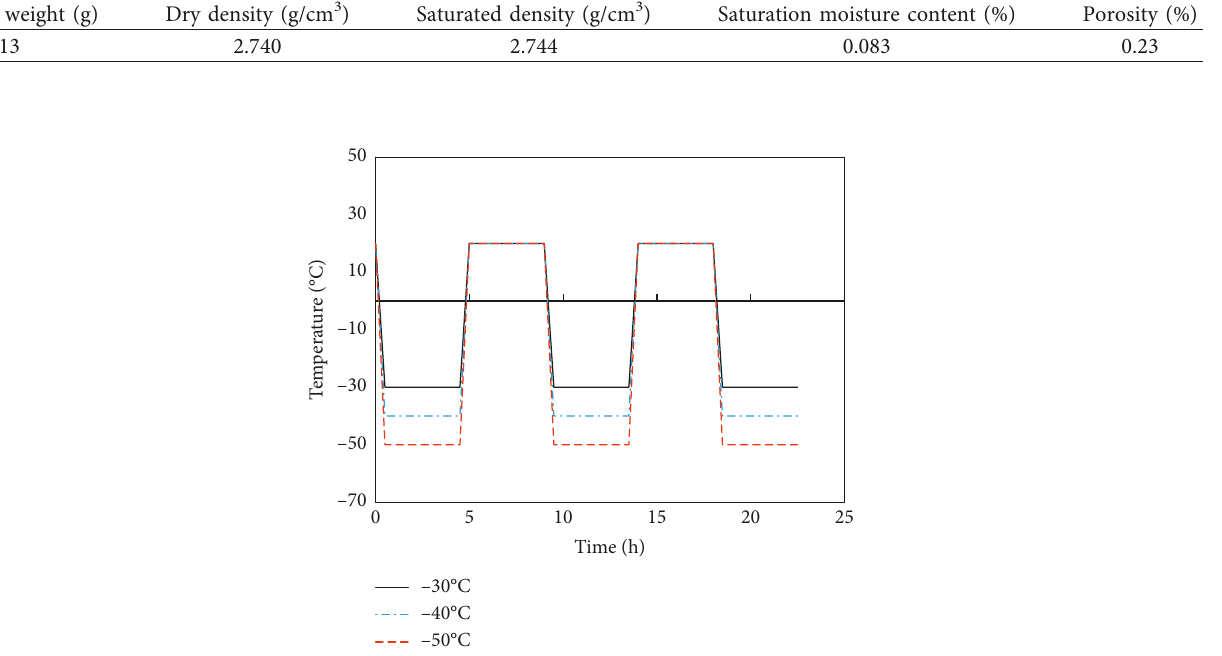
Figure 6: Temperature variation during freeze-thaw